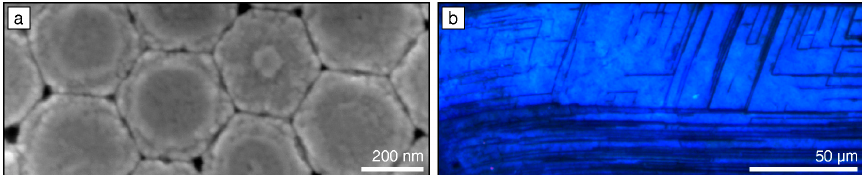
Figure 7. Post-depositional deformation features in precious opal from Andamooka. ( a ) Secondary electron image of HF acid-etched, hexagonal particles with concentric layering and subparticle structure. The pore space is significantly reduced compared to close-packed, ideal spheres. ( b ) Microphotograph of an opal-A photonic crystal between crossed polarizers showing thin black lines indicative of lattice displacement. Black lines on the right side intersect at an angle of ~70 ◦ . The lines are continuously bent toward the left